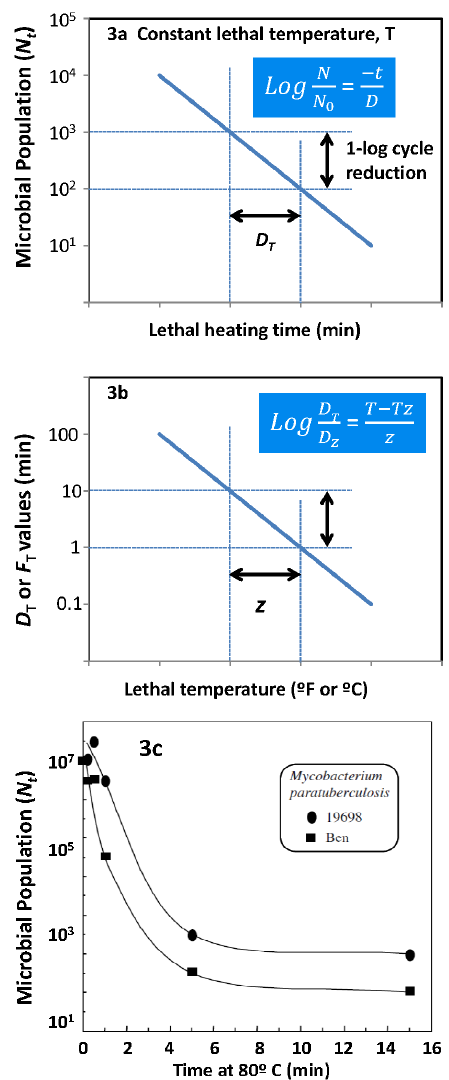
Figure 3. Microbial inactivation D - z model based on first order kinetics. ( a ) Decimal reduction time; ( b ) Thermal resistance; ( c ) Model deviation example. From reference [88].